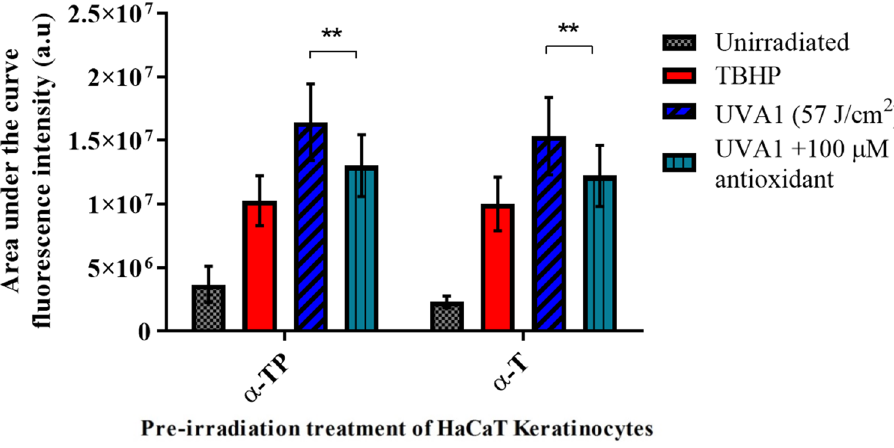
Figure 6. Effect of antioxidants (100 μM) on UVA1-induced ROS in HaCaT keratinocytes. Tertiary butyl hydroperoxide (TBHP—250 μM) was used a positive control. Fluorescence intensity analysis (AUC over